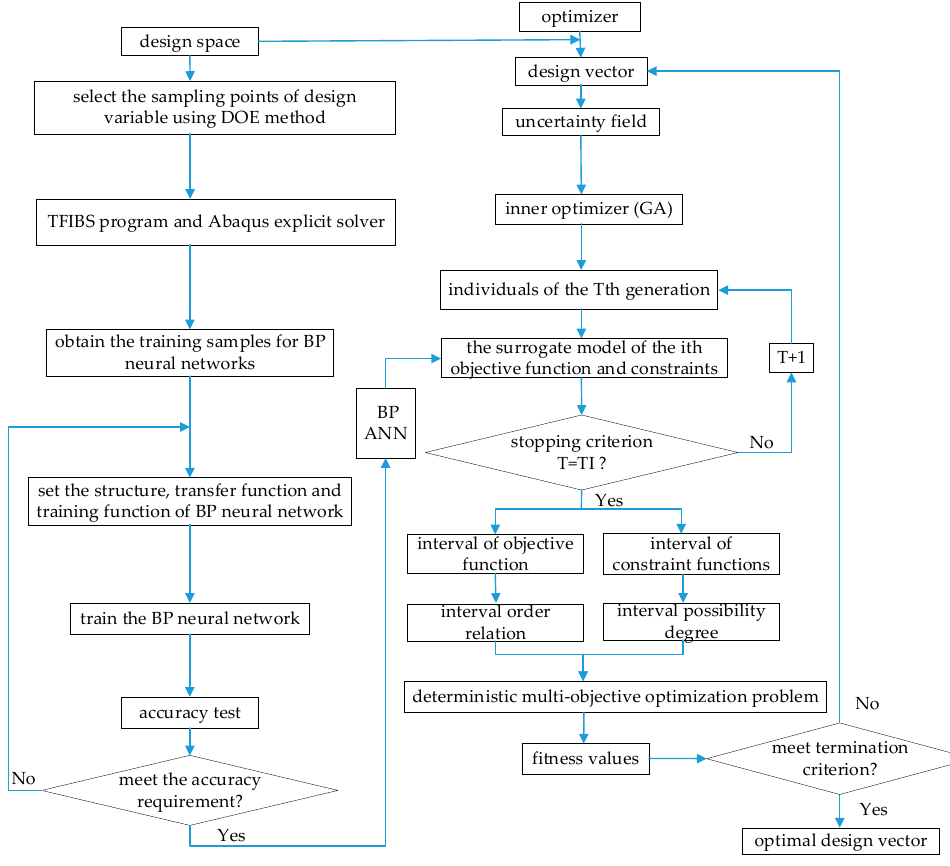
Figure 17. The solving process of the uncertain optimization.